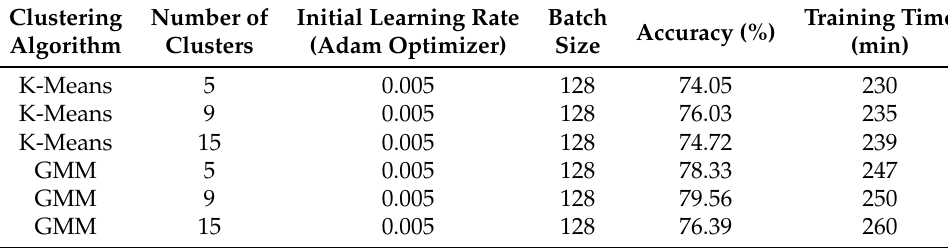
Table 3. Results of the Discriminative